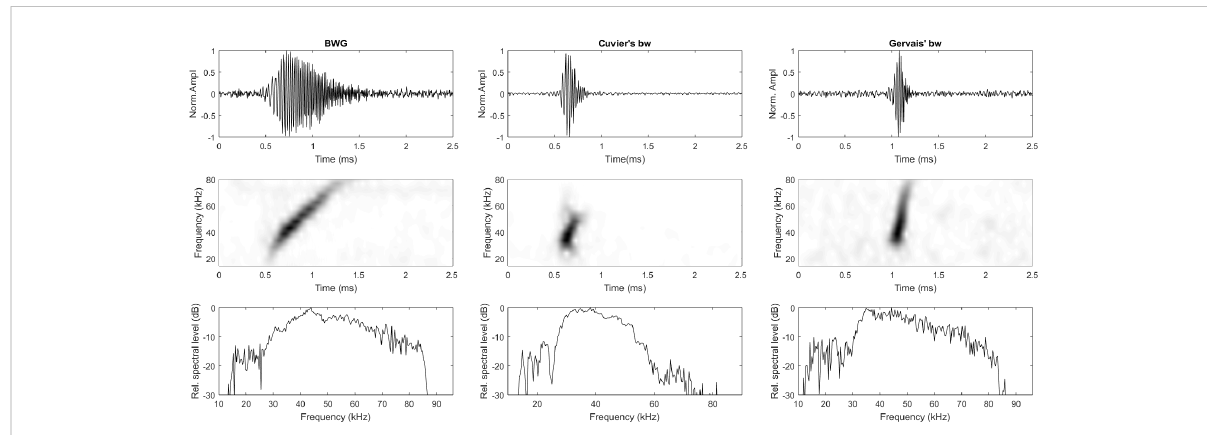
FIGURE 3 Representative acoustic portraits of three species of beaked whales detected in the Mississippi Canyon area: BWG ( fi rst column), Cuvier ’ s (middle column) and Gervais ’ (last column). The upper row is temporal signatures, middle row is spectrograms, and the bottom row is normalized power spectral density